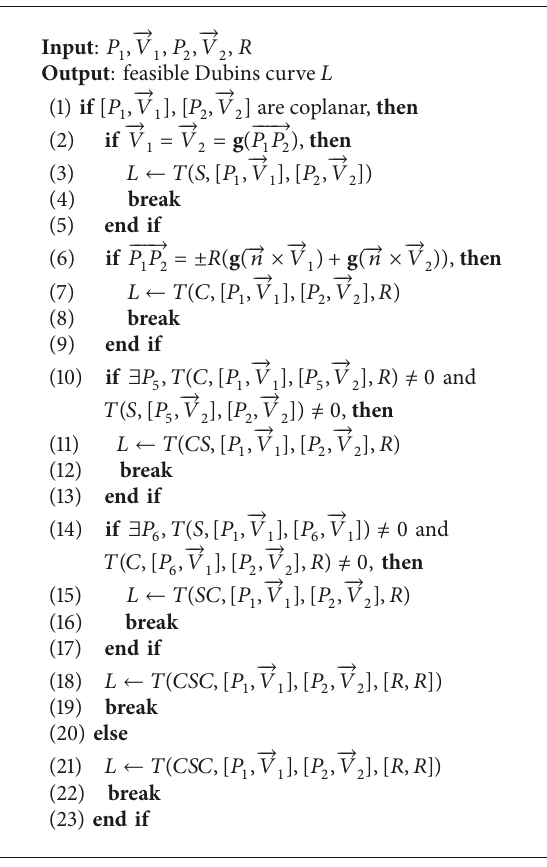
Algorithm 1: Dubins curve determination algorithm.